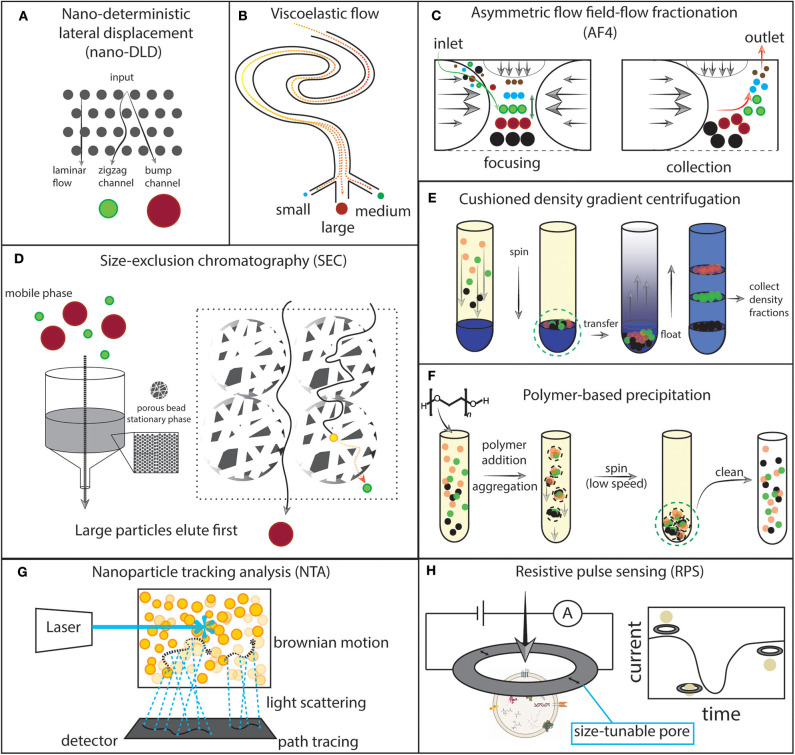
Schematics of selected experimental approaches for extracellular vesicles (EVs). (A) Nano-deterministic lateral displacement (nano-DLD). EVs are passed through a regularly-interspaced micropillar array with laminar flow. The pillar size and spacing determines how EVs of a specific size will migrate through the array. Smaller EVs output at the zigzag channel while larger EVs output at the bump channel. (B) Viscoelastic flow. Particles flowing through a viscoelastic medium are forced to their equilibrium position in the fluid channel and can then be collected. (C) Asymmetric flow field-flow fractionation (AF4). Opposing parabolic flows and an orthogonal flow focus particles to the center of the channel and then particles migrate to an equilibrium position. Then, the opposing parabolic flow is removed and particles elute from small to large. (D) Size exclusion chromatography (SEC). A stationary phase is built by packing nanoporous beads into a column. The biofluid is eluted in the mobile phase. Small particles take a longer path through the column by traversing through the beads, while larger particles travel outside of the beads. (E) Cushioned density gradient centrifugation. The sample is layered over a high density medium, then spun. Particles collect at the cushion made by the interface of the high density medium and the sample medium. The particles are then transferred to the bottom of a tube and layered with a density gradient. Upon centrifugation, the particles float upward to their equilibrium density position. The density fractions can then be collected. (F). Polymer-based precipitation. Addition of a volume-excluding polymer to the sample induces aggregation and precipitation which then allows for low-speed centrifugation to collect the precipitated particles. The sample can then be cleaned of the volume-excluding polymer and other potential contaminants. (G) Nanoparticle tracking analysis (NTA). A laser is shone onto the sample and scattered photons are detected continuously by video. Brownian motion is traced and correlated with particle properties. (H) Resistive pulse sensing (RPS). A current is applied to a nanopore and recorded over time. EV motion through the pore results in a measurable current drop which can then be correlated with particle properties.